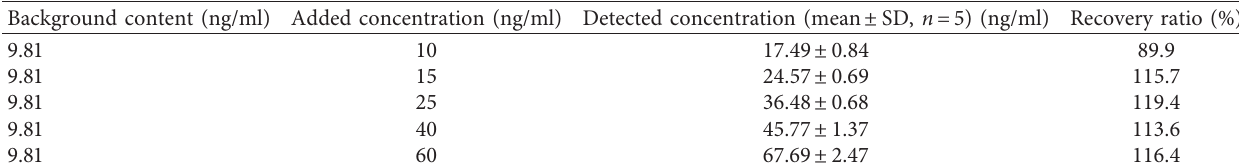
Table 1: Recovery of IgG in human serum by electrochemiluminescence immunosensor.